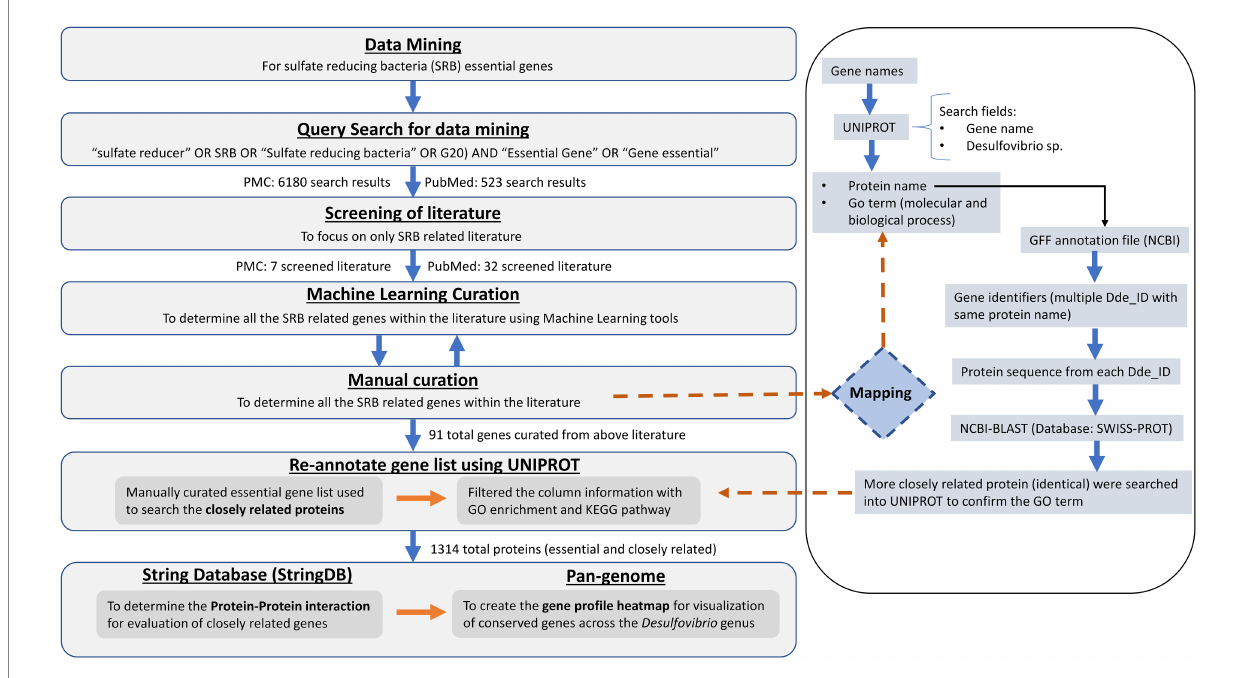
FIGURE 3 Overall workflow for the mining of essential genes of SRB from literature databases and subsequent identification of genes as essential in OA